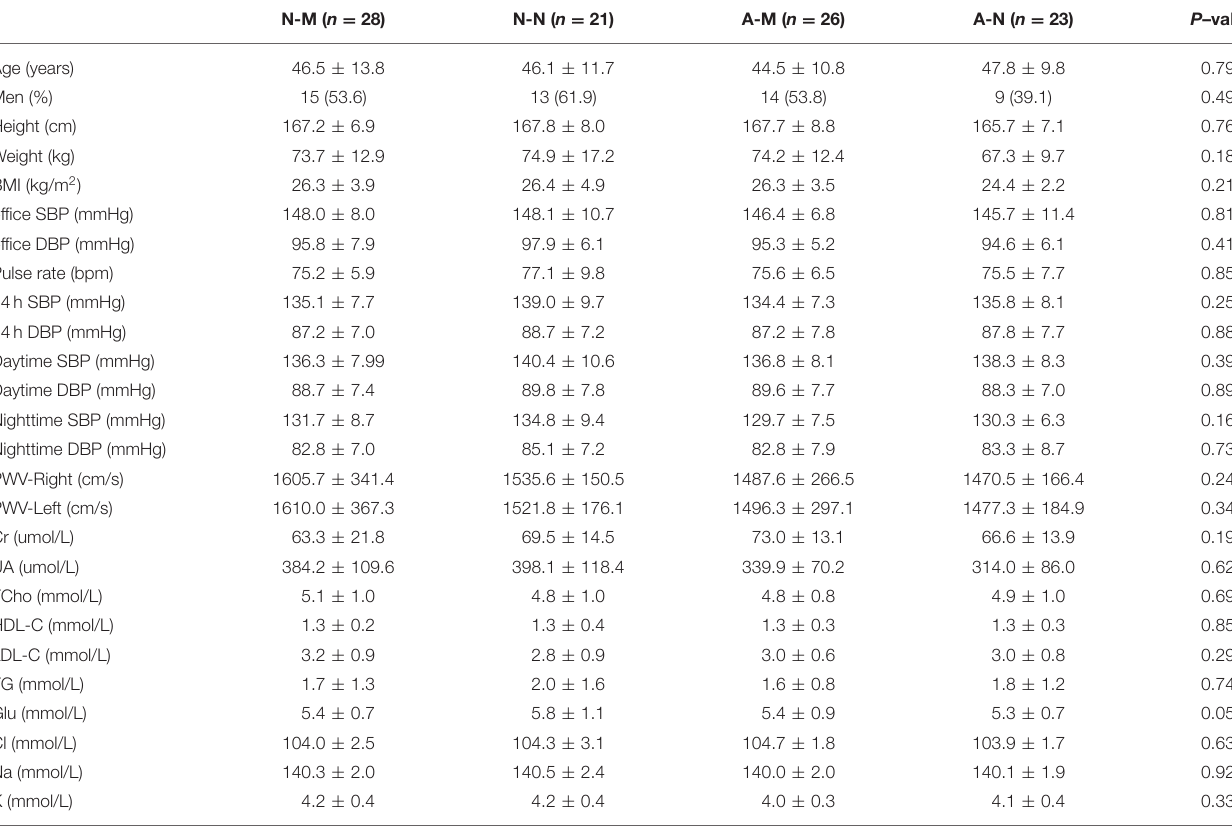
TABLE 1 | Baseline demographic and clinical characteristics of the